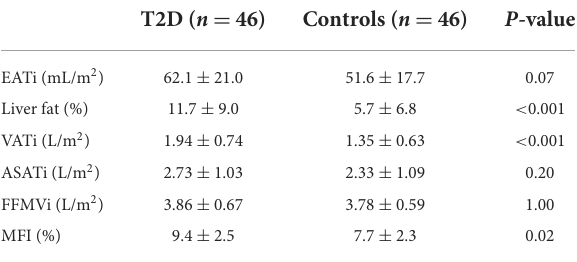
TABLE 1 Group comparison of demographic and basic clinical data. TABLE 2 Group comparison of regional body composition